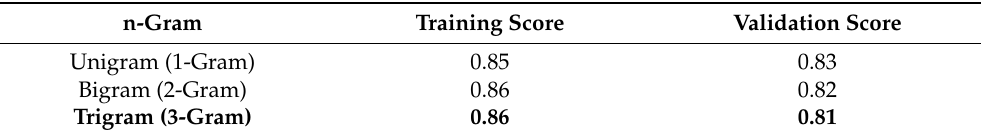
Table 6. Using the SGDClassifier , the data were trained and validated to obtain the best TF-IDF transformed and n-Gram